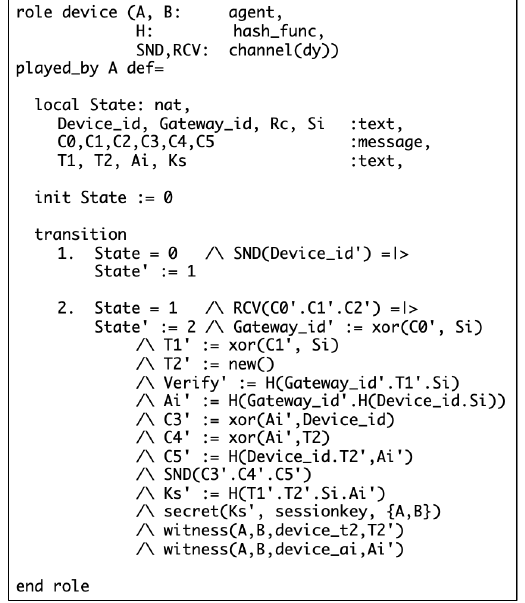
Figure 7. Specification of the SD role for low security risk.